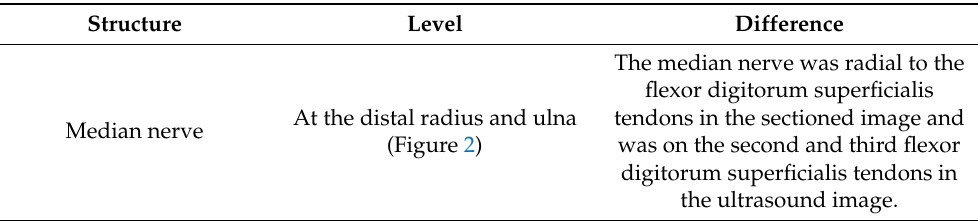
Table 2. Difference of the structures between the sectioned and ultrasound images. Structure Level Difference The median nerve was radial to the flexor digitorum superficialis At the distal radius and ulna tendons in the sectioned image and Median nerve (Figure 2) was on the second and third flexor digitorum superficialis tendons in the ultrasound